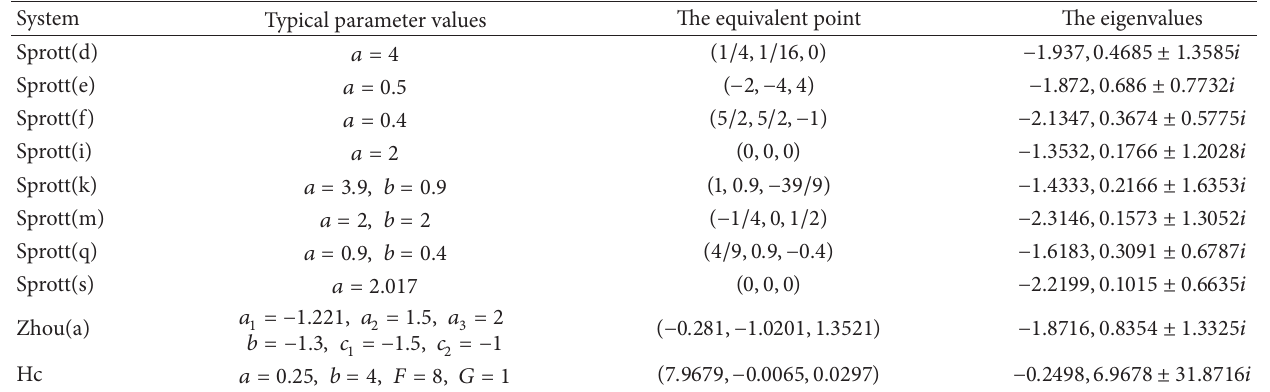
Table 1: The systems with one equilibrium point.